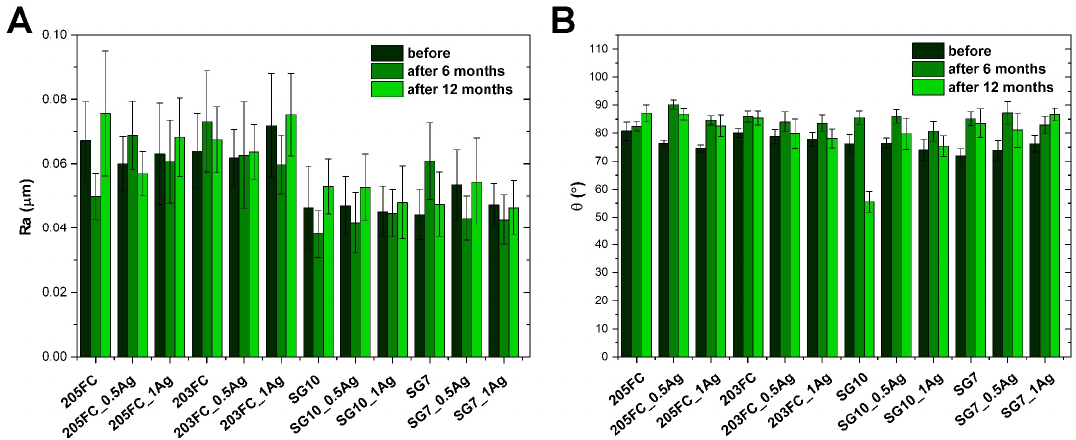
Figure 3. The arithmetical mean roughness ( A ) and static water contact angle ( B ) of the materials before and after 6-month and 12-month incubation in deionized water.